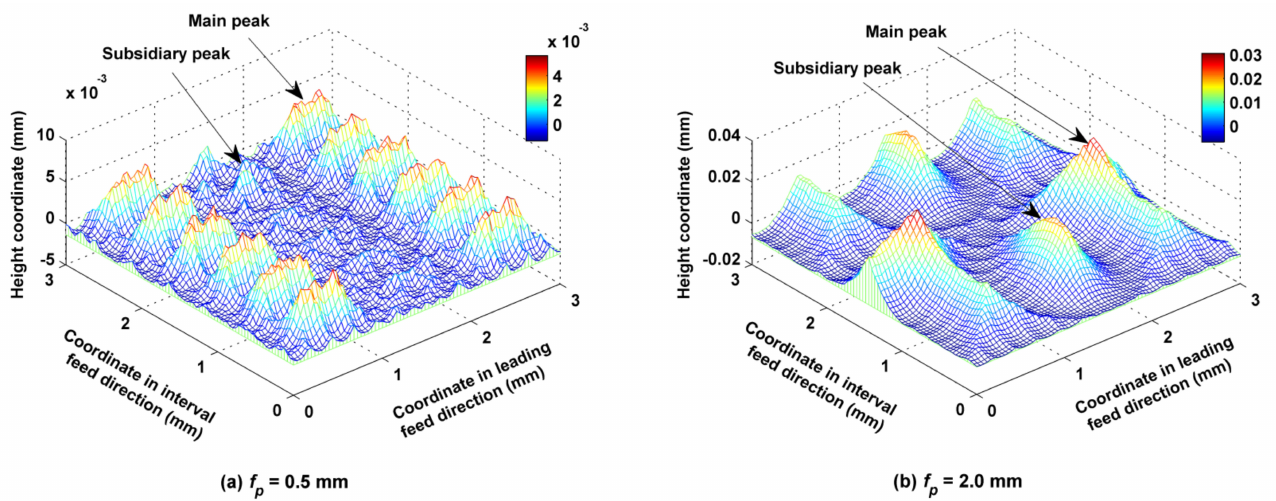
Figure 18. Ball-end trochoidal milling micro surface topography comparisons between different leading